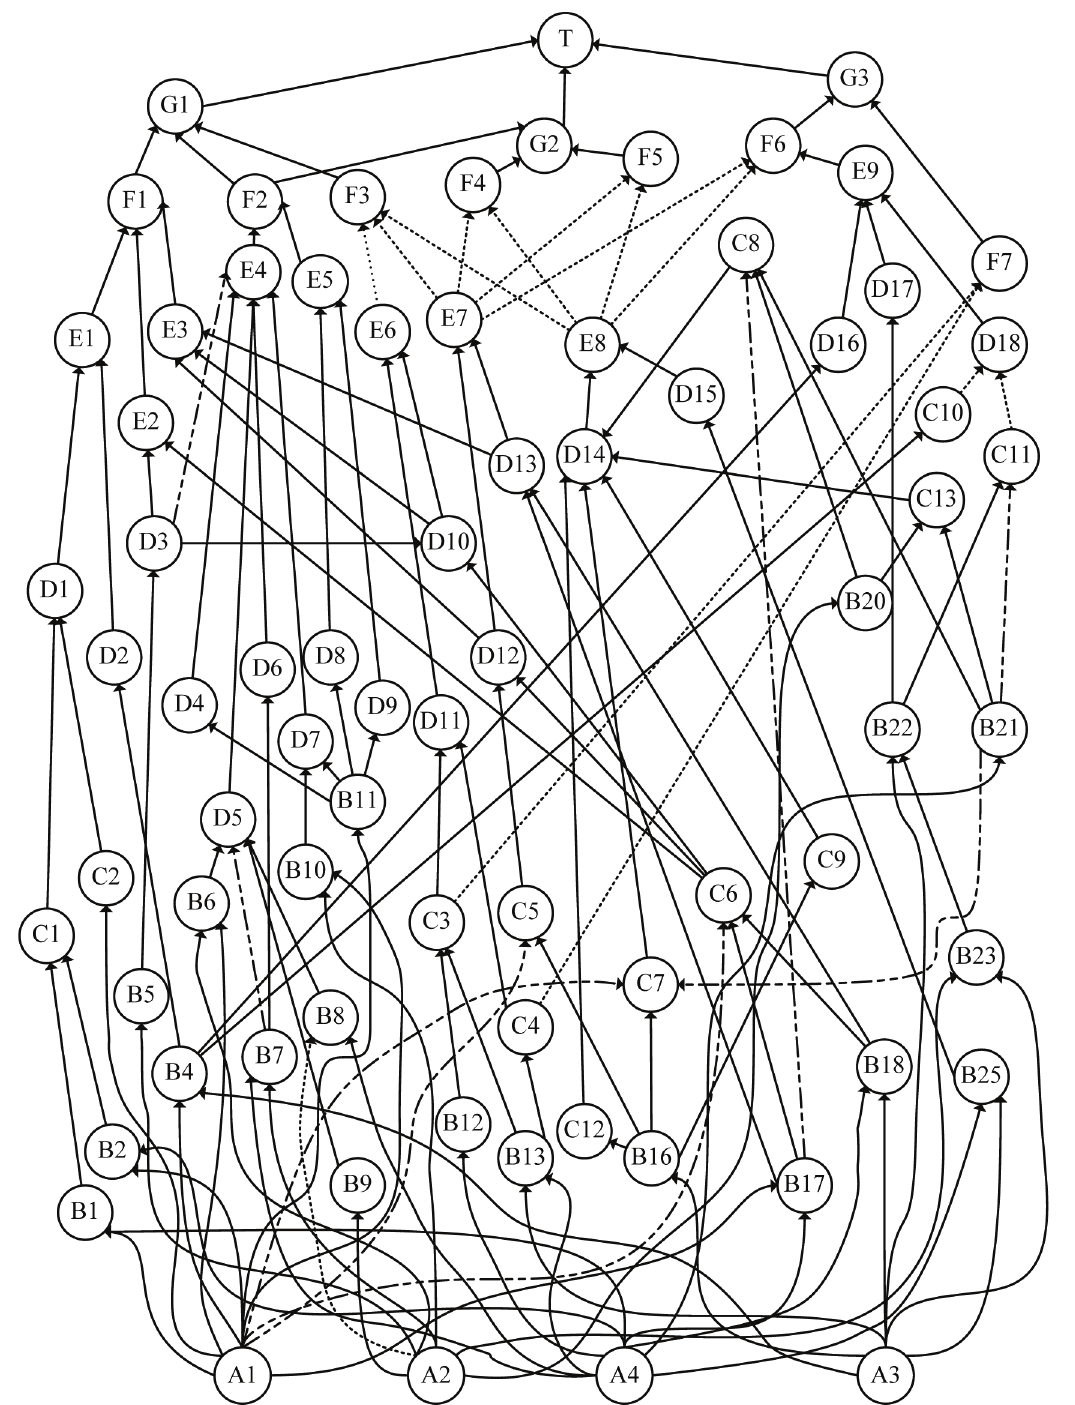
Fig. 5. Bn of falling accidents at steel construction